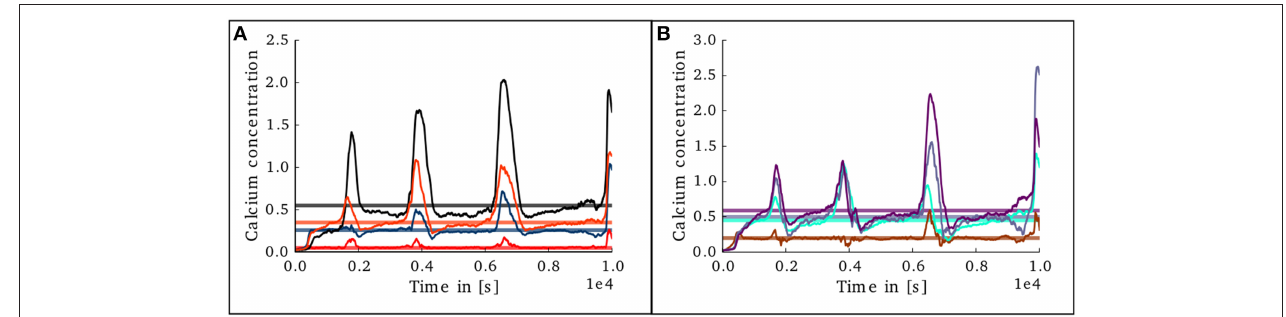
FIGURE 10 | Evolution of calcium concentration in each layer of the cortical microcircuit model with an unstable set of parameters. (A) Shows the calcium concentration in the excitatory populations in layers II/III (red), IV (blue), V (black), and VI (orange). (B) Shows the calcium concentration in the inhibitory populations in layers II/III (brown), IV (cyan), V (gray), and VI (purple).